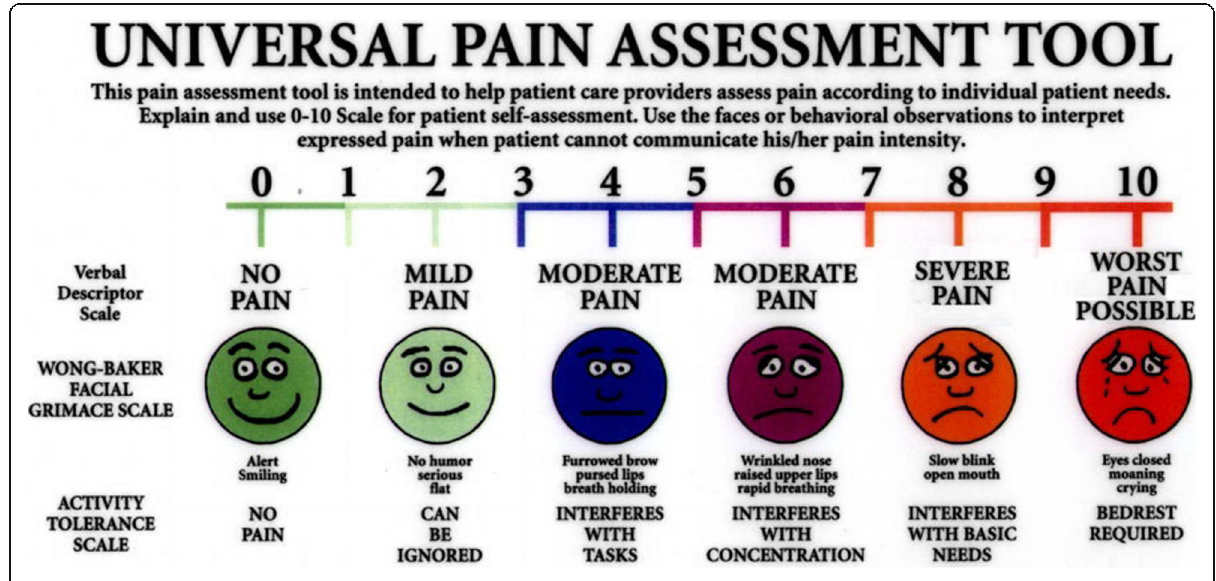
Fig. 1 Universal visual analog scale for pain assessment [15]